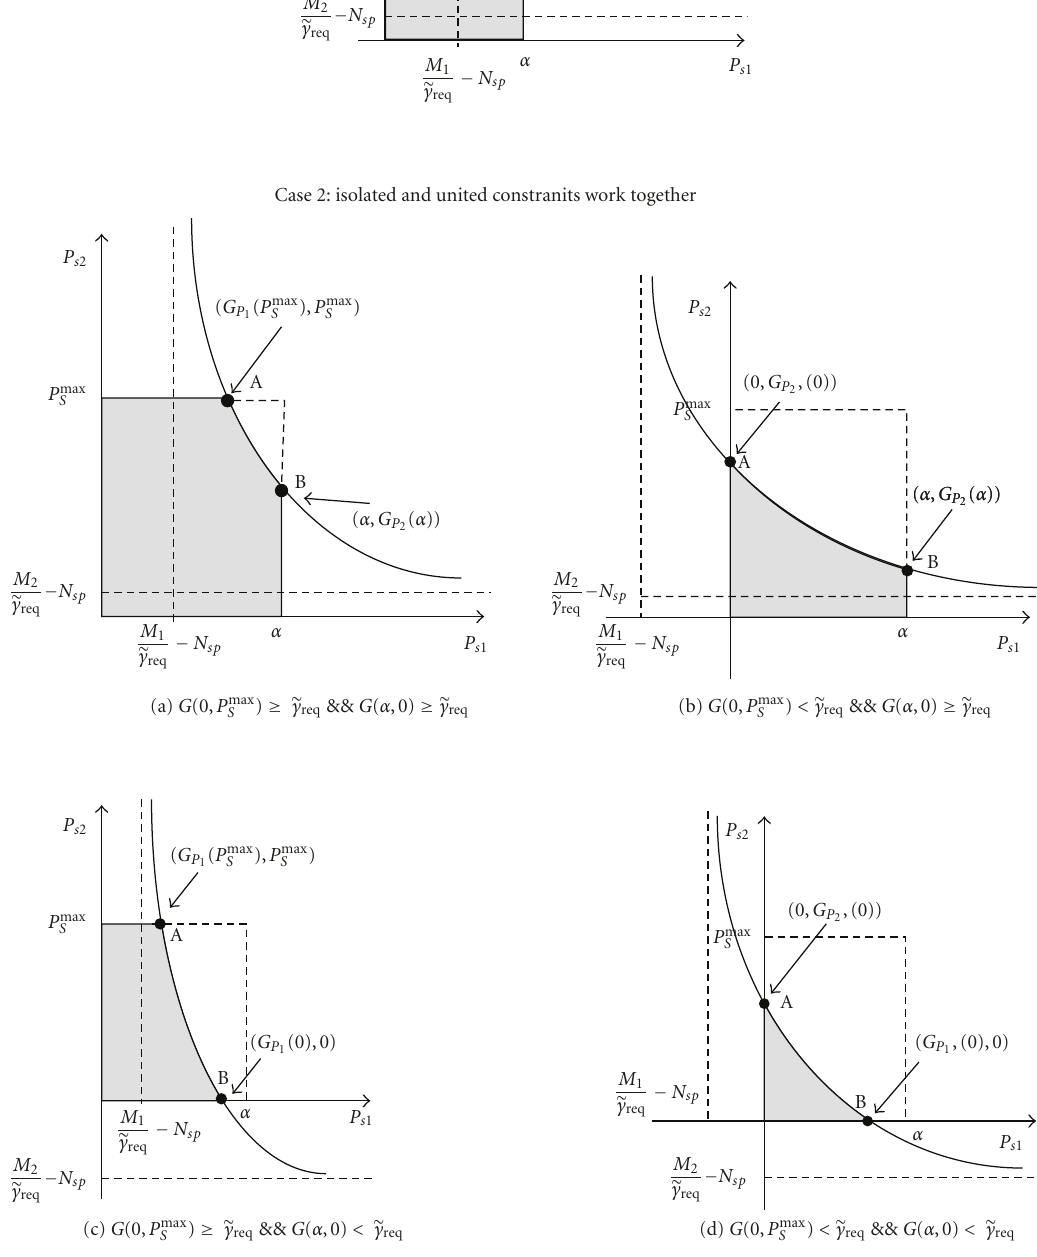
Figure 3: The feasible region for P s 1 and P s 2 . Given fixed P r , the best transmit power pair ( P s 1 , P s 2 ) is shown by point A in the case of ) ≥ (cid:5) γ req . Otherwise, the best transmit power pair is either achieved on point A or point B for each G ( α , P max S